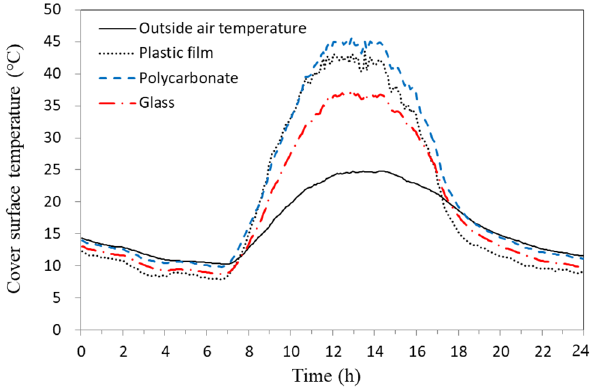
Figure 7. Variations in the outdoor air temperature and inner cover surface temperatures of greenhouses covered with di ff erent covering materials (12 − 13, 19 − 20, and 26 − 27 October 2019).